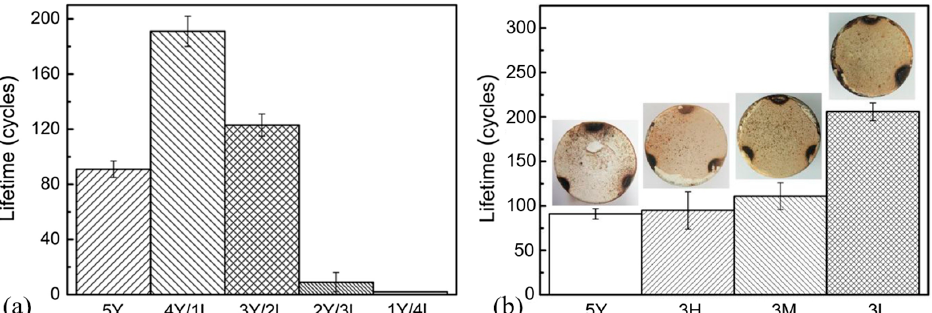
Figure 43. Lifetime of DCL TBCs under gradient thermal cyclic tests at 1300 °C TC surface and 940 °C backside surface: ( a ) equivalent thermal insulation with different thickness ratio ( b ) equivalent thermal insulation with different modulus [217,218] .